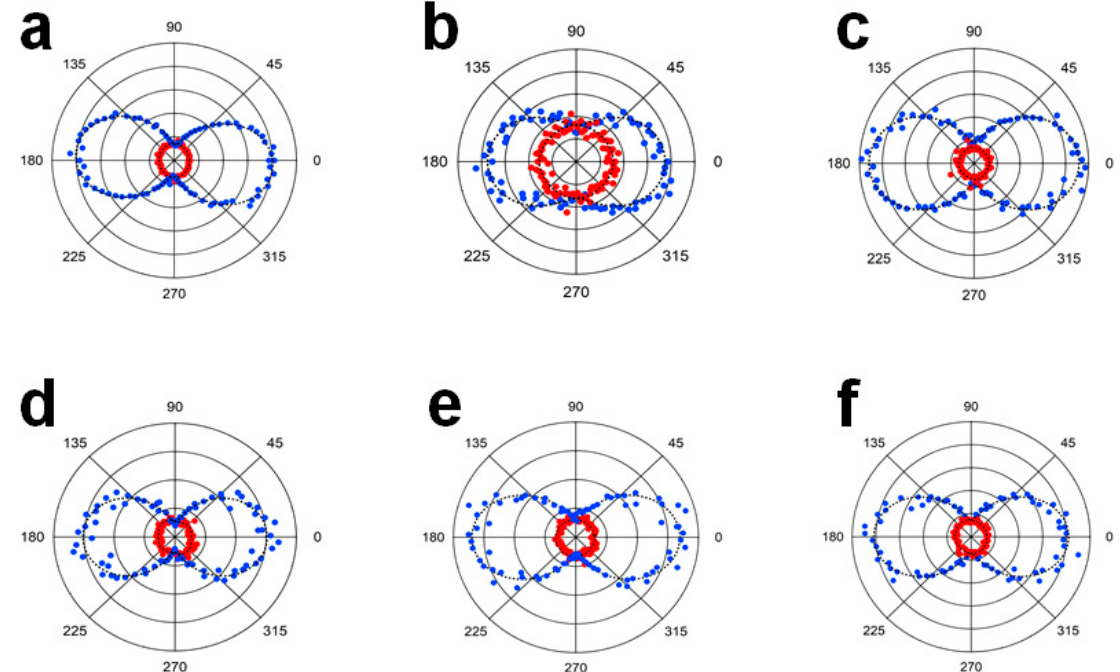
Figure 7. Polar plots of HRS intensities as a function of the polarization angles of the incident light. The blue and red data points correspond to vertical and horizontal harmonic polarization of the HRS intensities, respectively. ( a ) Core LN, ( b ) AuSeeds, ( c ) LN@BPEI@AuSeeds100, ( d ) LN@BPEI@AuSeeds300, ( e ) LN@BPEI@AuSeeds1000 and ( f ) LN@BPEI@Au- Seeds3000.